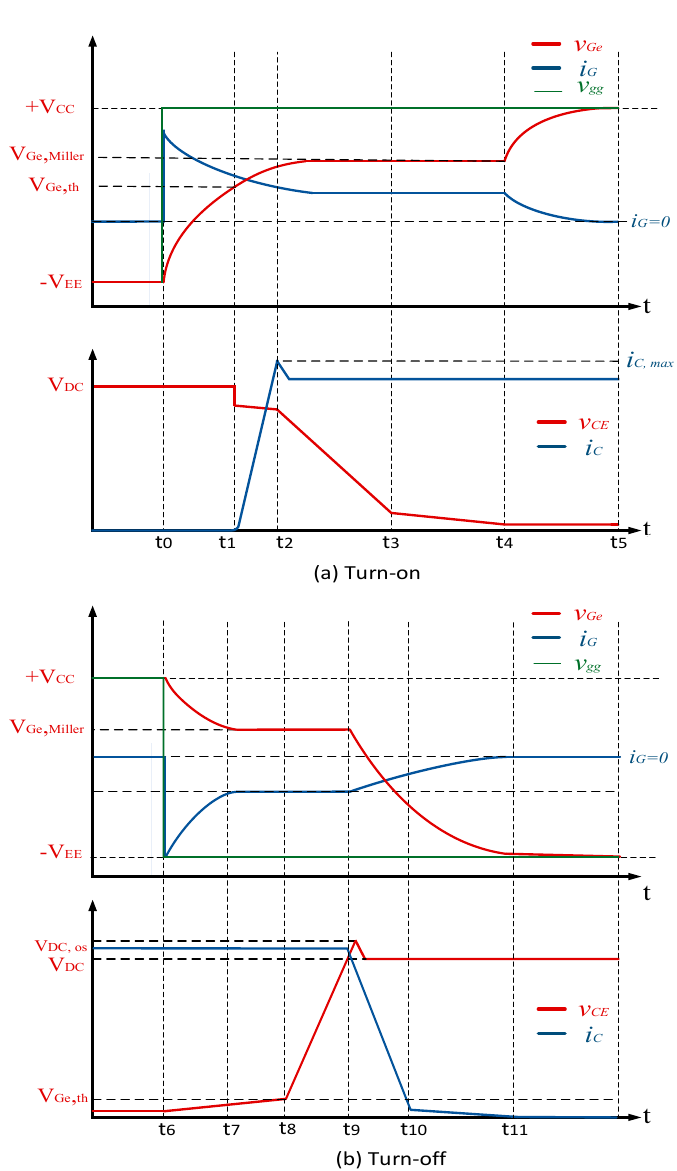
Figure 1. The intrinsic behavior of insulated gate bipolar transistors (IGBTs) at turn-on ( a ) and turn-off ( b ). Switching and controller operation time marked by gray background.